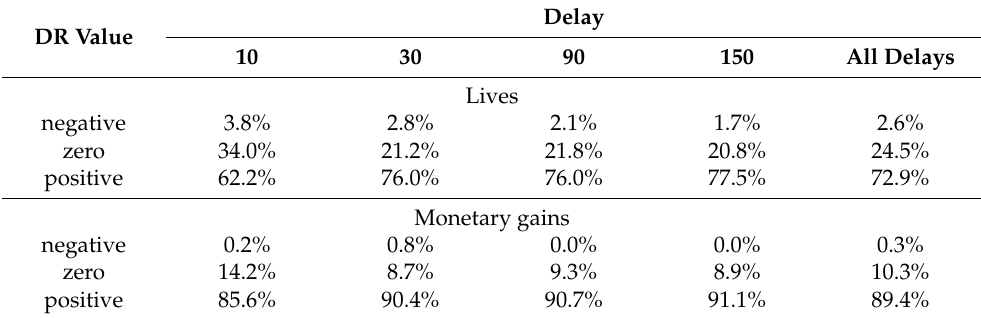
Table 2. Share of negative, zero and positive discount rates for lifesaving program and monetary